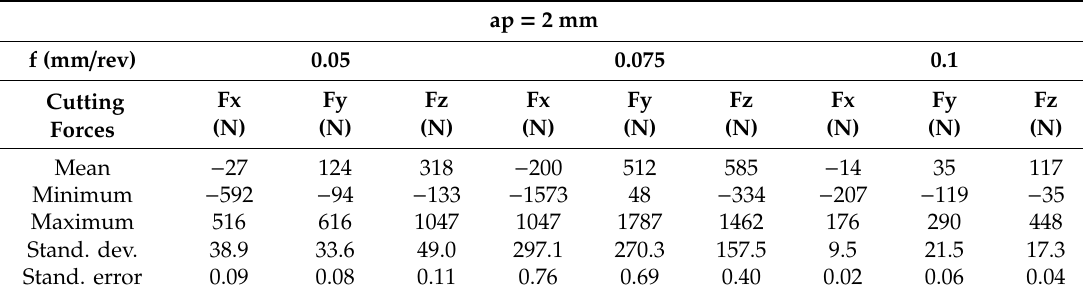
Table 5. Statistical analysis of cutting forces for ap = 2.0